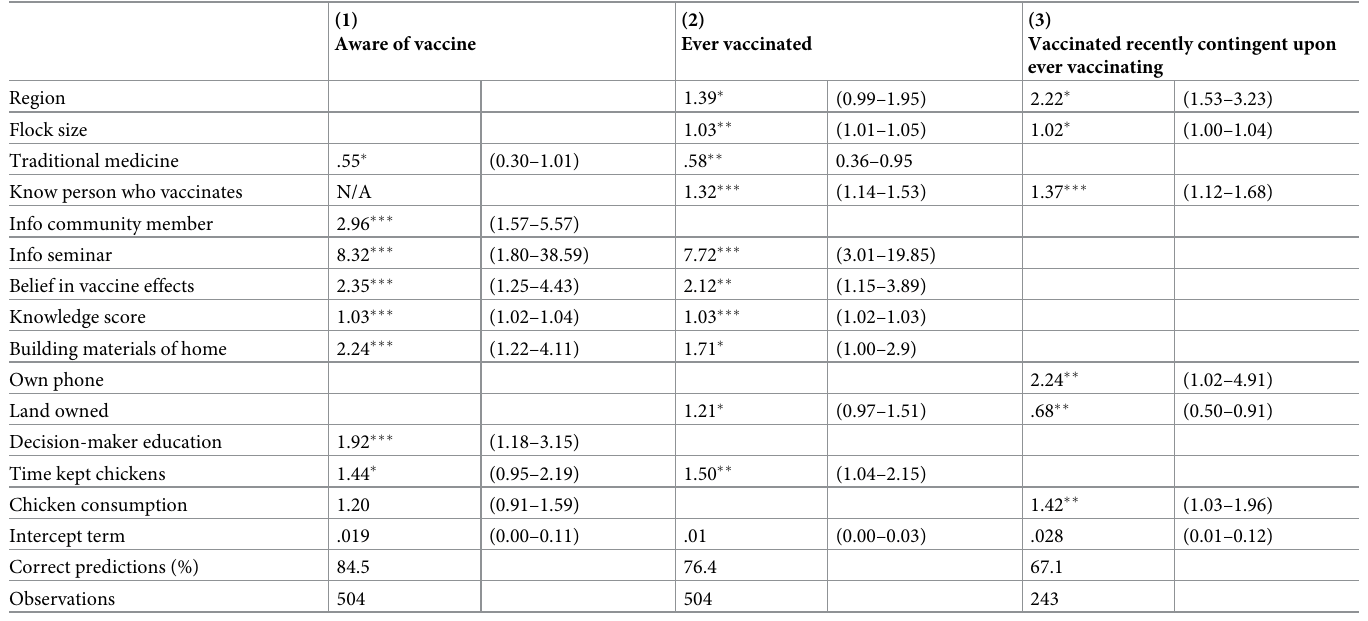
Table 3. Determinants of ND vaccine adoption using three logistic regression models, AOR (95% CI). (1) Aware of